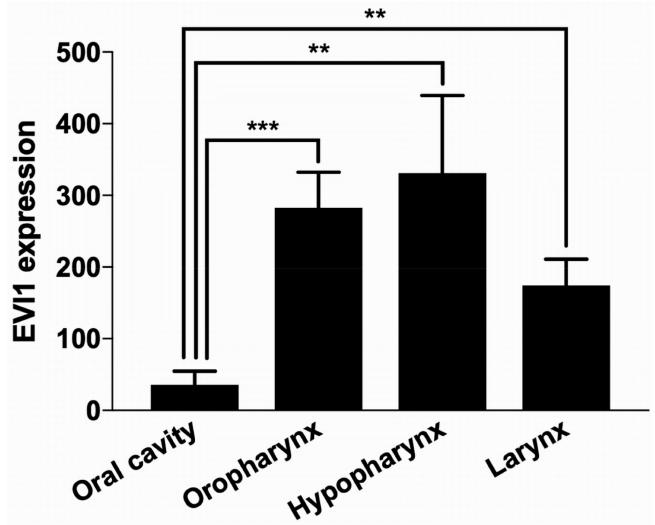
Figure 2. Correlation of EVI1 expression in di ff erent HNSCC sites. The primary tumors were grouped by their site of origin and the mean EVI1 expression of each group was determined. The EVI1 expression in tumors of the oral cavity is significantly lower than in other HNSCC sites (unpaired t-test, statistically significant (** p < 0.01; *** p <